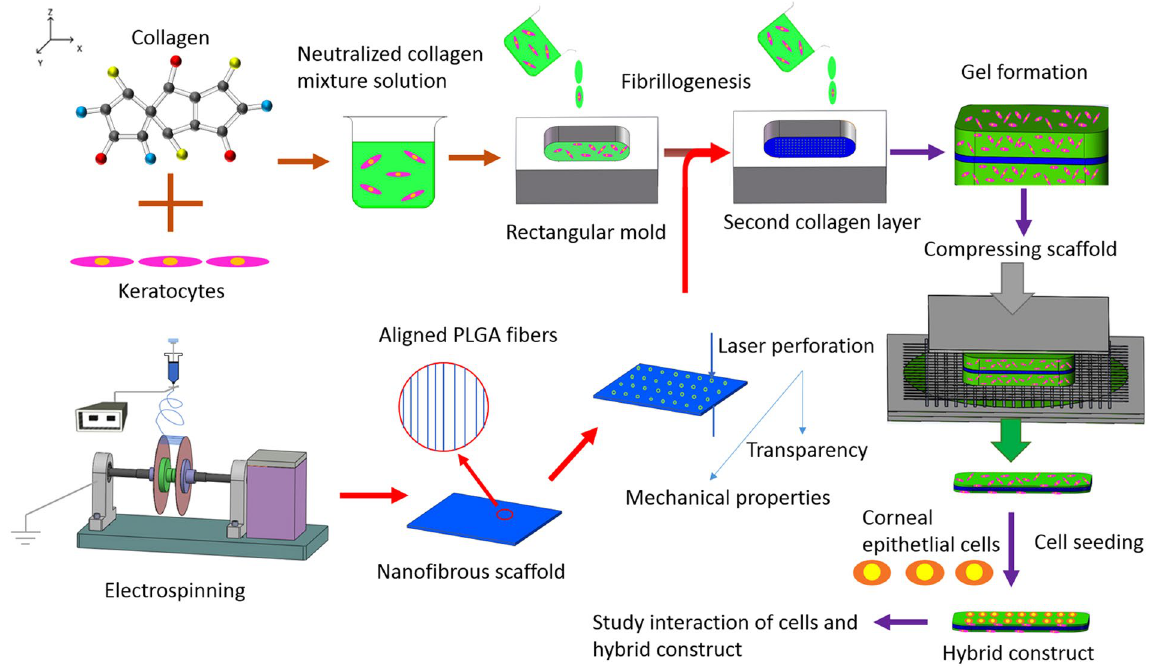
Figure 1. The schematic illustration of the experimental